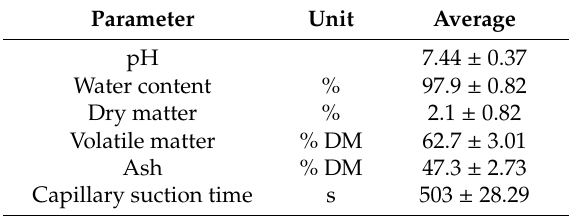
Table 3. Properties of the anaerobic sludge used in the